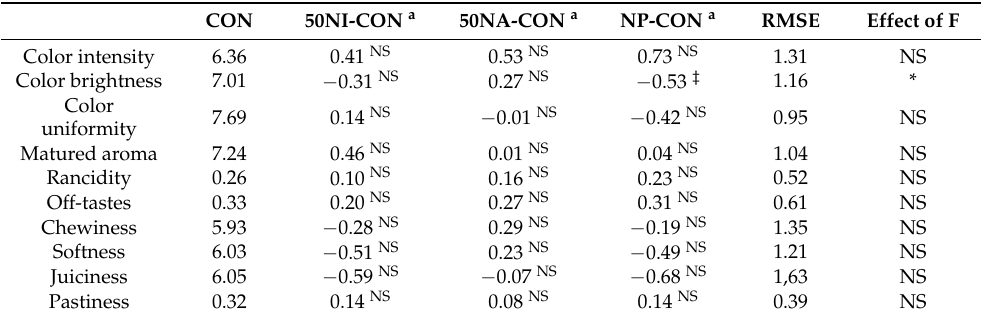
Table 5. Sensory traits of dry-fermented